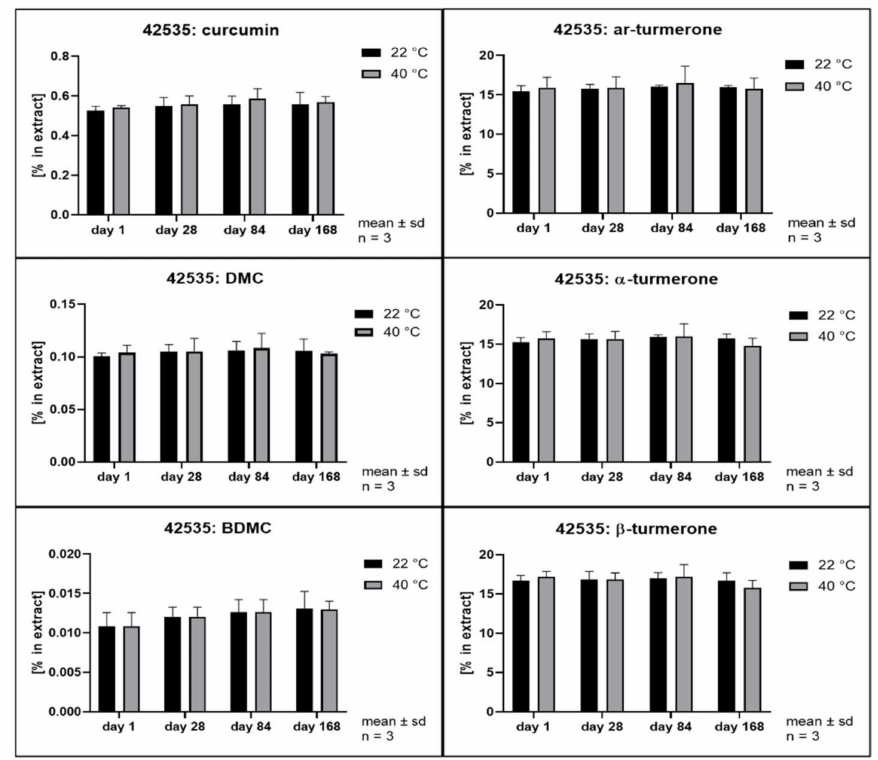
Figure 10. Contents of individual curcuminoids and turmerones in scCO 2 extracts throughout storage, extraction at 425 bar and 35 ◦ C